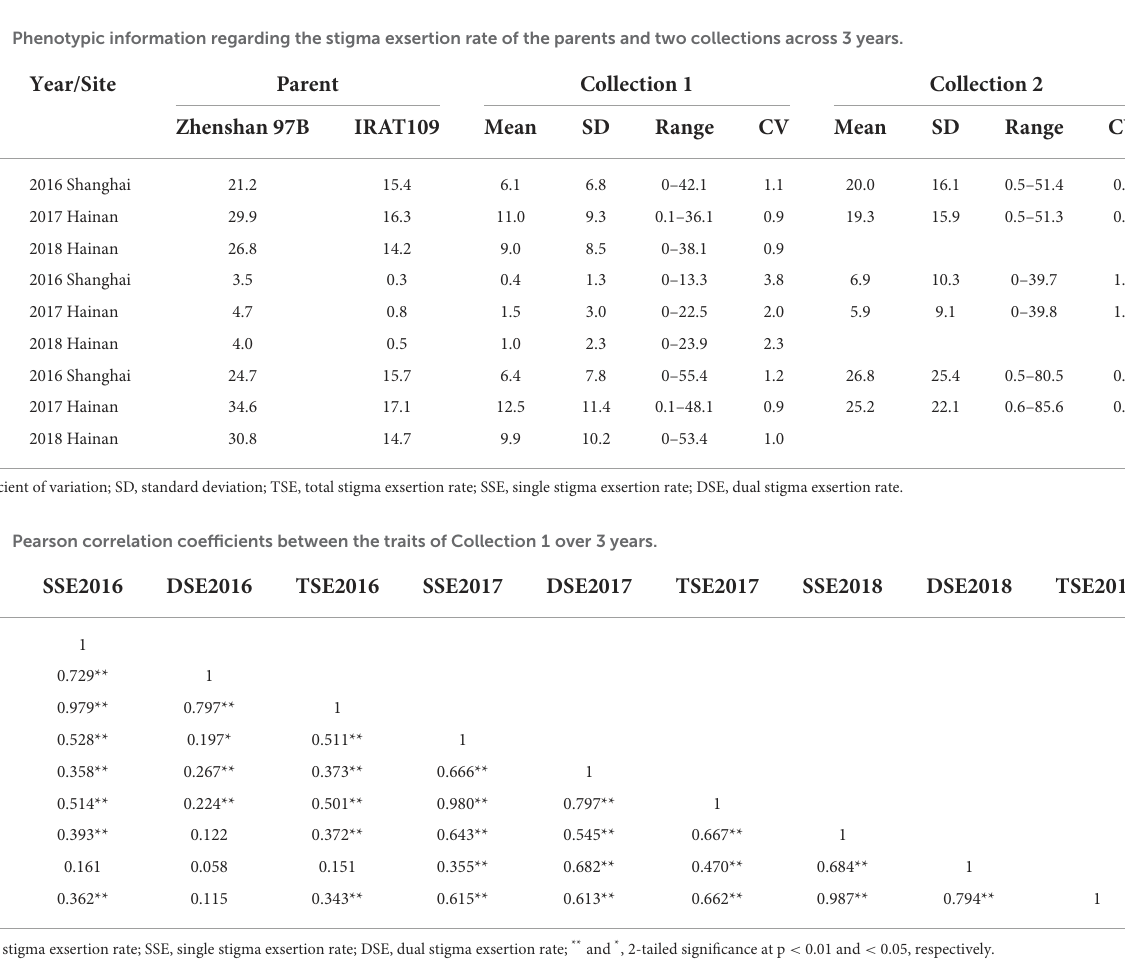
(Supplementary Figure 3). The ratio of environmental variation to phenotypic variation [V(E)/V(P)] was 24.67%, while the ratio of variation due to environment x genotype and phenotypic variation [V(GE)/V(P)] was 4.40%, thereby suggesting that environmental factors only had a minor